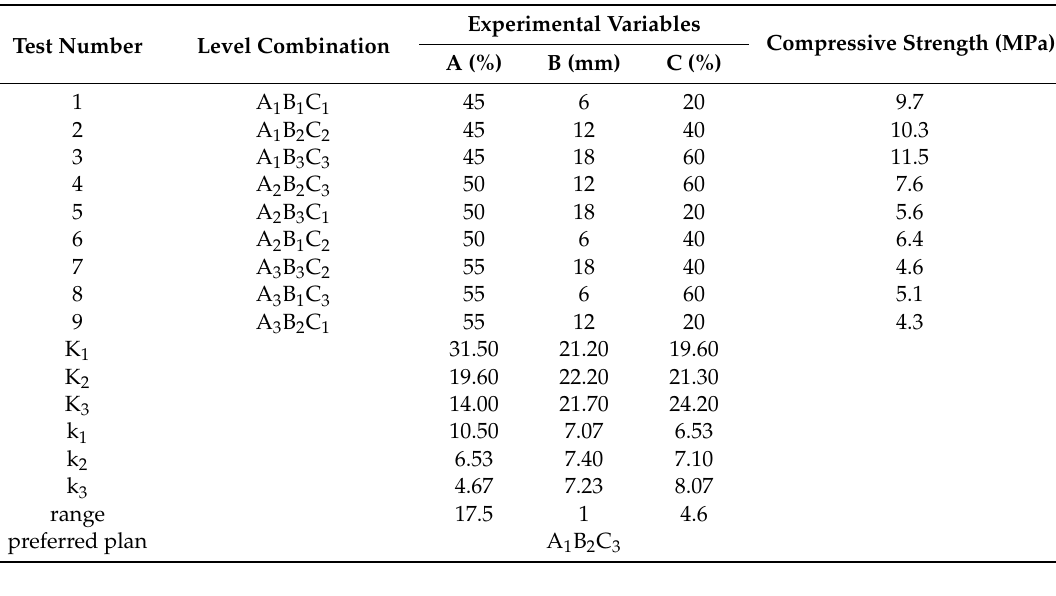
Table 3. Statistics pertaining to the measured compressive strengths.